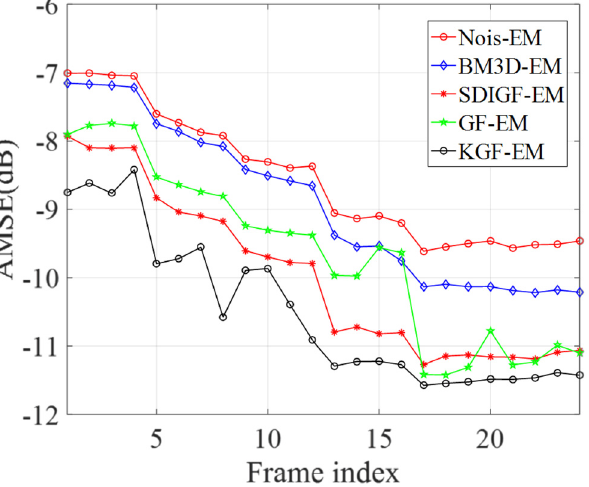
Fig 5. AMSEs of MLEM reconstructed image frames from the sinograms denoised by different methods.